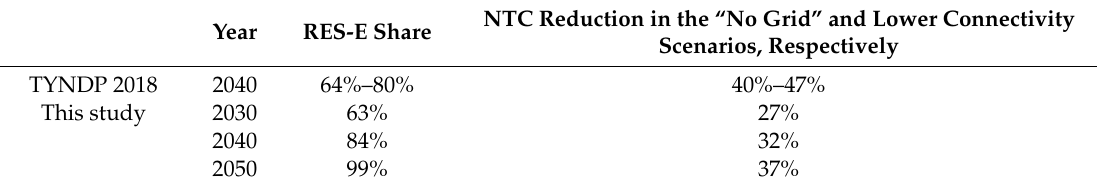
Table 5. Comparison of RES-E share in electricity demand and assumptions for NTC reduction in the TYNDP 2018 and this study. Source: Reference [24] and own calculation. NTC Reduction in the “No Grid” and Lower Year RES-E Share